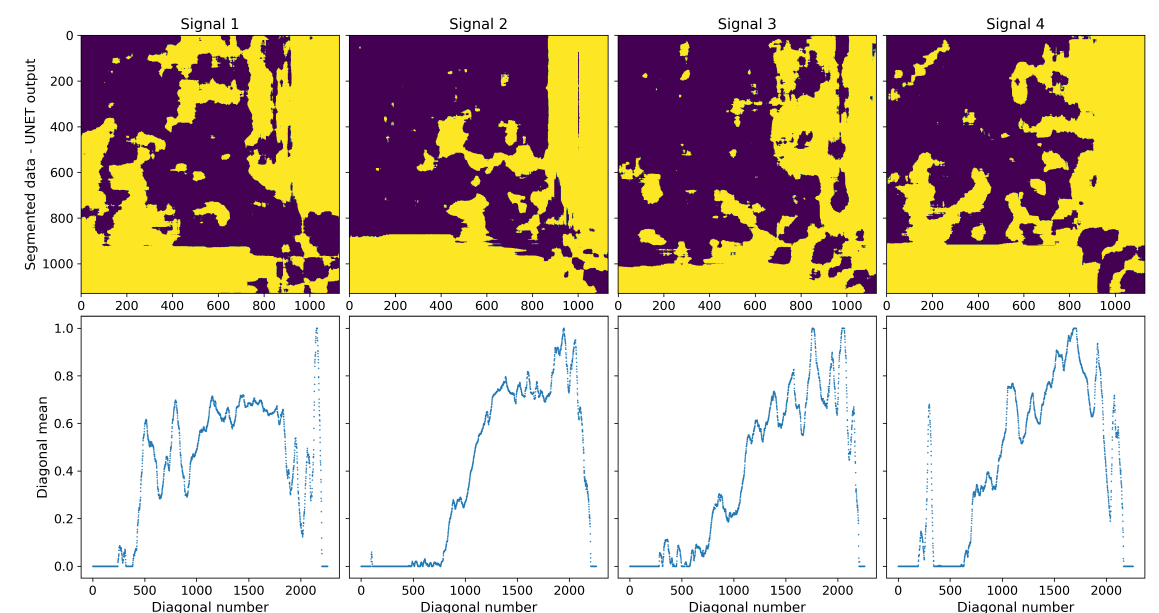
Figure 9. Mean of the values ( second row ) of the segmented distance matrices ( first row ) on each anti-diagonal.